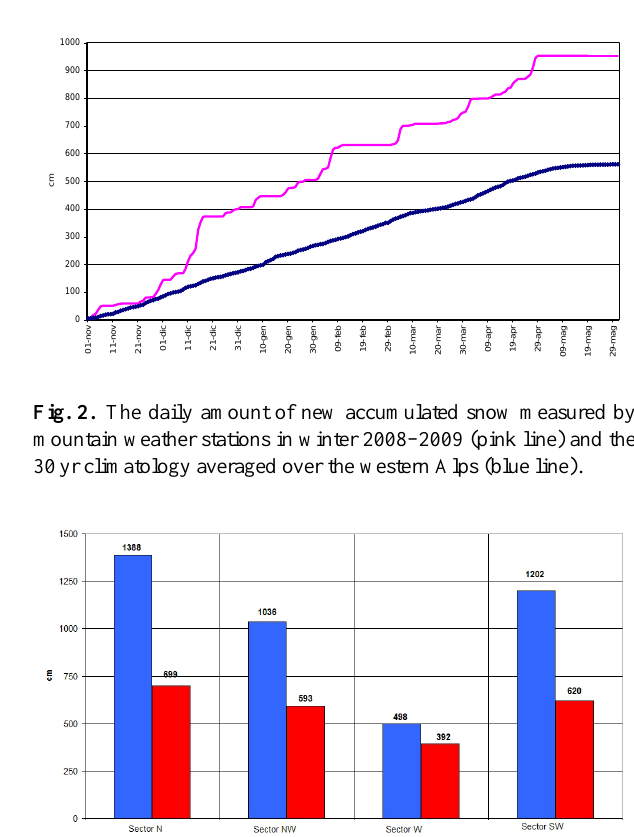
Fig. 3. The total amount of new accumulated snow in the period Figure 3. The total amount of new accumulated snow in the period November 2008 - May 2009 November 2008–May 2009 (blue) and in the 1996–2009 climatol- (blue) and in the 1996-2009 climatology (red) for four alpine sectors (N, NW, W, SW) ogy (red) for four alpine sectors (N, NW, W, Several snowfall events affected also the plains and main towns. 14 significant snow events have been recorded in Cuneo and 9 in Torino from December 2008 to March 2009. The main one was in January 2009: 35 cm of new snow in 36 h, with an intensity of 25cm/24h, the maximum intensity recorded in the last 20 years (the previous one was 17cm/24h in 1997). The intensity value is above the 90th percentile of the new snow measured in 24h distribution considering only the snowy days. These results agree with the 2008-2009 winter season snow anomaly studies on the southern alpine range (e.g., Valt M. and P. Cianfarra, 2009). 2 Societal impacts of the snowfalls The impact scenarios related to the snow emergency are different according to the geographical and anthropic territory features. During the winter 2008-2009 in the mountains, several natural avalanche releases, characterized frequently by large size and heavy destroying power, affected villages and caused interruptions of the main and secondary road systems both down in the valleys and in small villages road access, requiring a long time for the complete and safe snow removal and road re-opening. The avalanches often caused the service breakdowns and damages to the infrastructures in the built-up areas and to the forest heritage. The destructive power of the avalanches was due to their characteristics: the large amount of new snow triggered powder